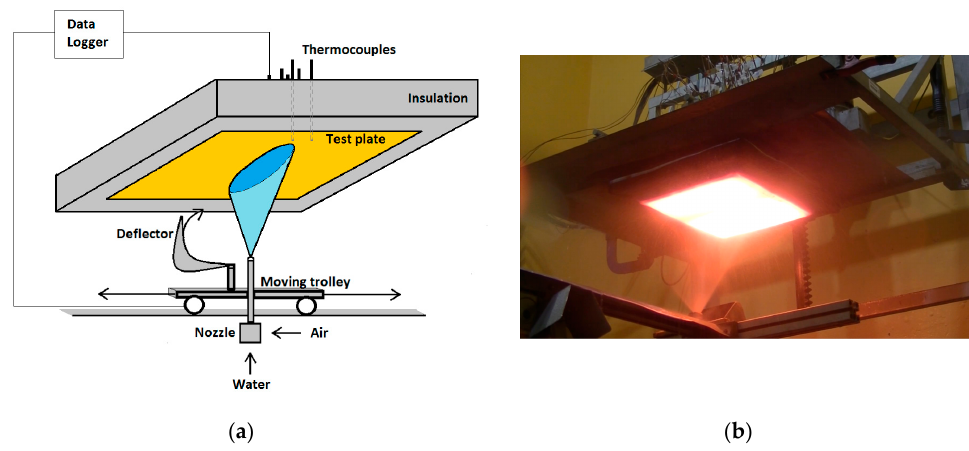
Figure 2. Scheme of experiment ( a ), test plate with thermocouples and nozzle with deflector on moving trolley for the heat transfer coefficient (HTC) measurement ( b